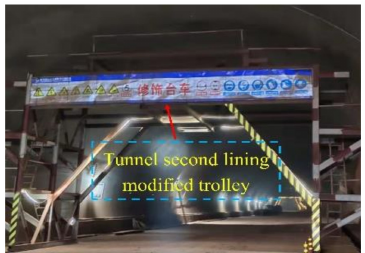
Figure 4. Tunnel second lining modified